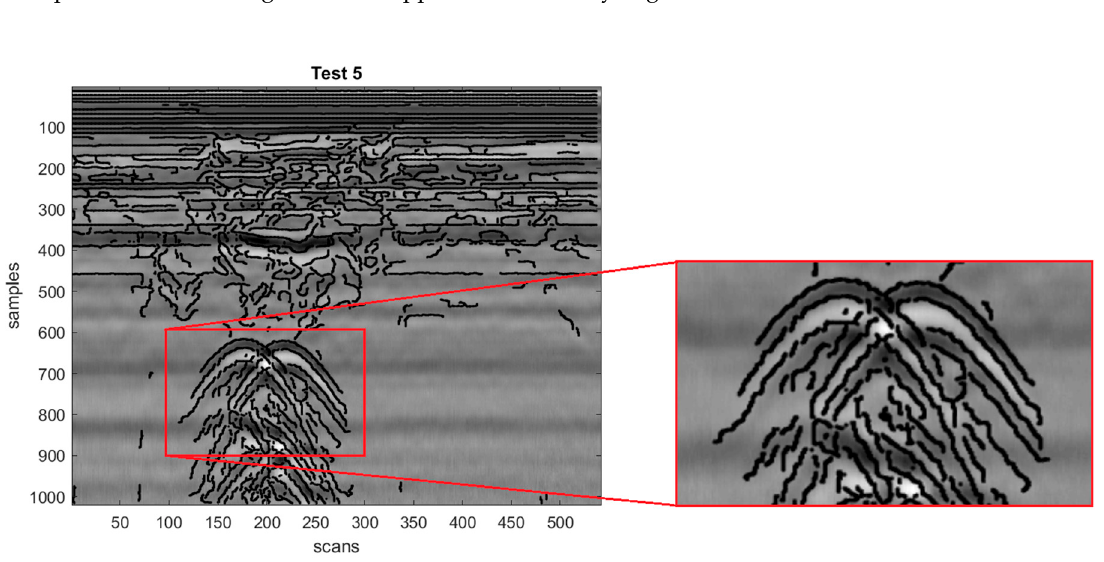
Figure 3. Illustrative schemes, showing typical clusters of edge pixels obtained after the application of Canny edge detector to GPR data: ( a ) group of edge pixels that can be fitted by using a linear